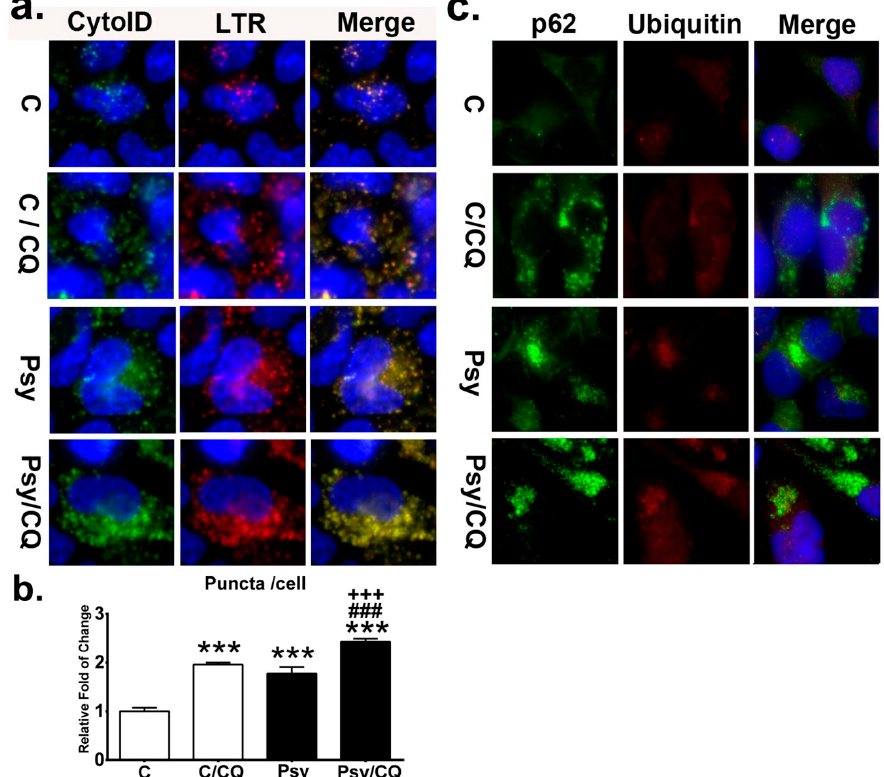
Figure 9. Accumulation of autolysosomes and p62 aggregates by impaired autophagic flux. ( a ) Autolysosome was determined by the colocalization of the Cyto-ID fluorescence and LysoTracker Red (LTR) in MO3.13 cells treated with / without psychosine (Psy) concomitant with / without chloroquine (CQ) and counter-stained with Hoechst. ( b ) Quantification of autolysosome puncta in cells. ( c ) Cytoplasmic deposition of p62 and ubiquitin by chloroquine. Cells were double labeled with anti-p62 and anti-ubiquitin and counterstained with DAPI. Values are expressed as mean ± S.D. ( n = 3). Statistical significance *** p < 0.001 in comparison to control (C). C / CQ vs. Psy, or Psy / CQ, ### p < 0.001. Psy vs. Psy / CQ, +++ p < 0.001.